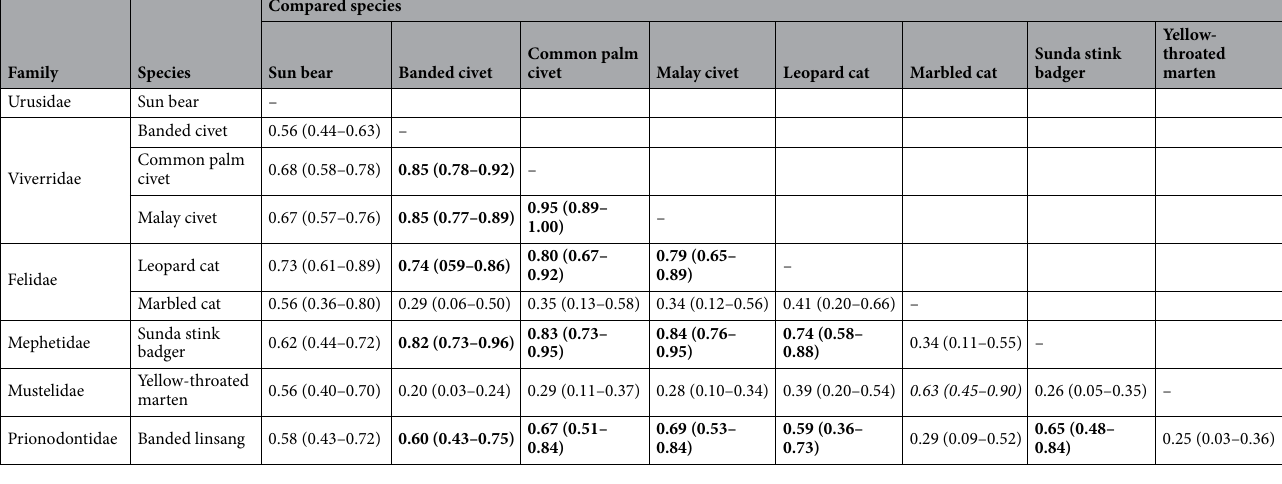
Table 3. Coefficient of overlaps (Δ 1 and Δ 4 ) of temporal activity patterns between carnivore species. The values in parenthesis indicate 95% confidence interval. The bold cells indicate overlaps between nocturnal species, and italics indicates those between diurnal